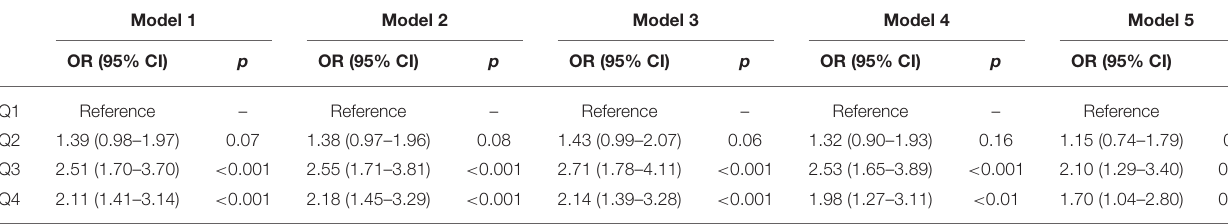
TABLE 3 | Logistic regression analysis of the association between YKL-40 and carotid atherosclerotic plaque